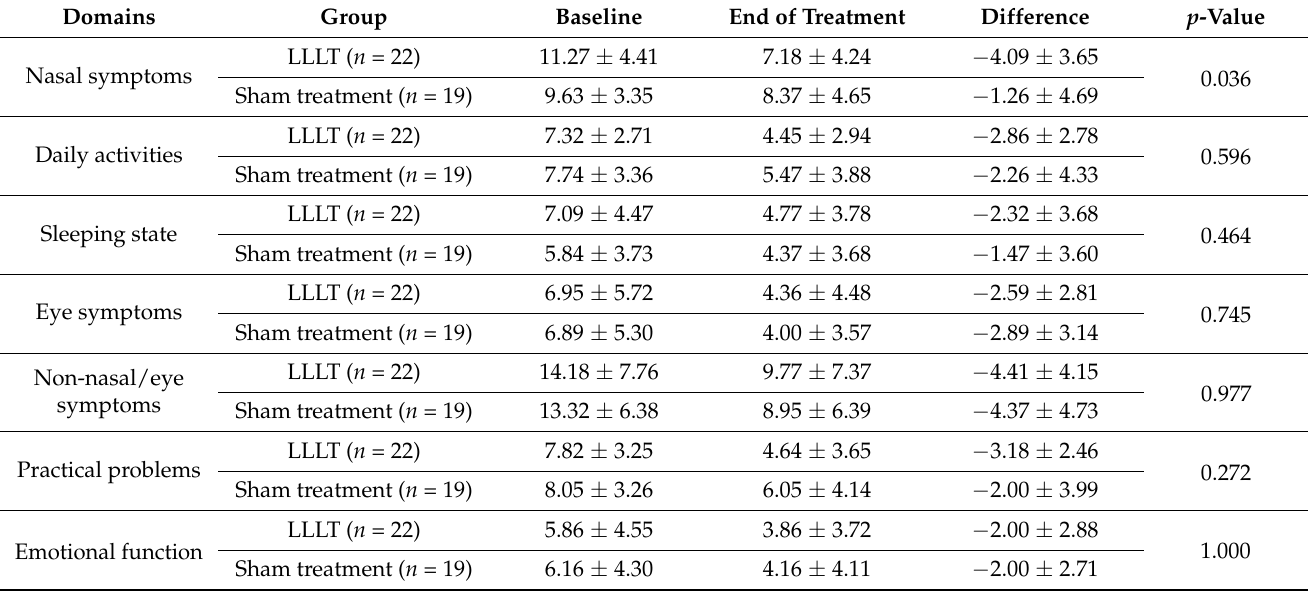
Table 6. Treatment effects (RQLQ domains, mPP set).